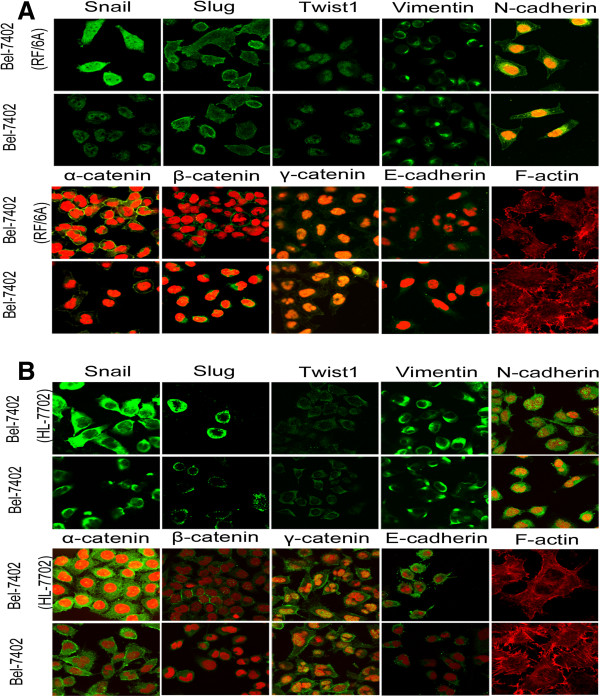
Immunofluorescence of epithelial and mesenchymal markers, EMT-related transcription factors and F-actin. (A) Confocal microscopy analysis of Bel-7402 cells co-clutured with RF/6A cells for 72 days. (B) Confocal microscopy analysis of Bel-7402 cells co-clutured with HL-7702 cells for 60 days. The green signal represents corresponding protein staining and the red signal indicates nuclear DNA staining by propidium iodide (PI).